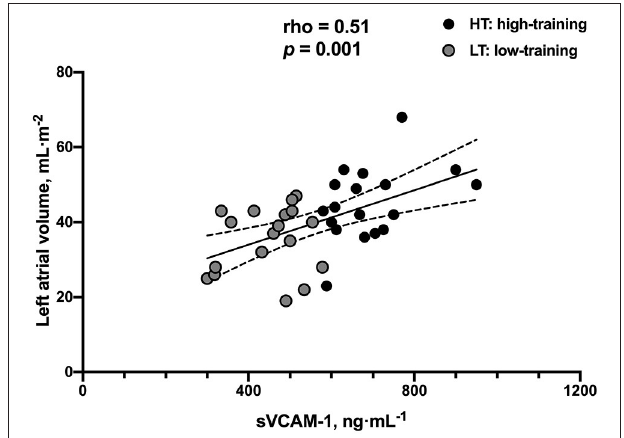
FIGURE 3 | Correlation between sVCAM-1 blood sample levels and left atrial volume in long-distance runners ( n =